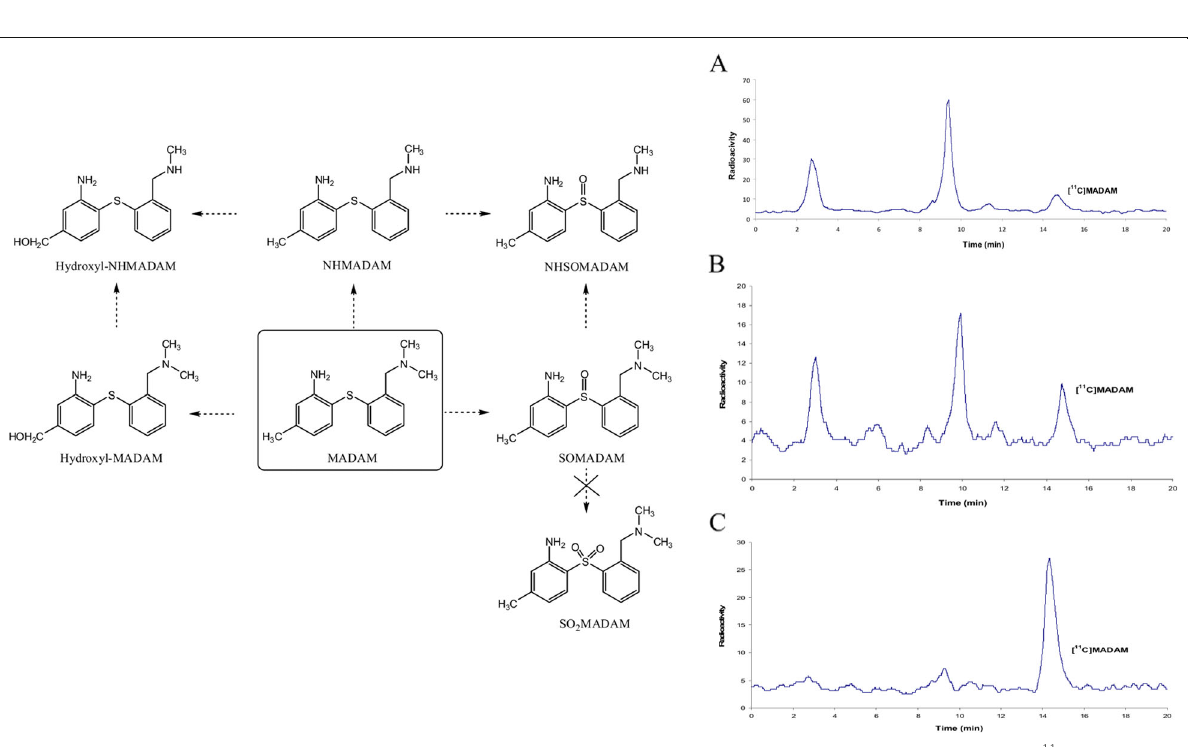
Fig. 7 Proposed in vitro metabolic pathways of MADAM. Radio-HPLC chromatograms of rat urine samples after perfusion of ( a) [ 11 C]MADAM, ( b)